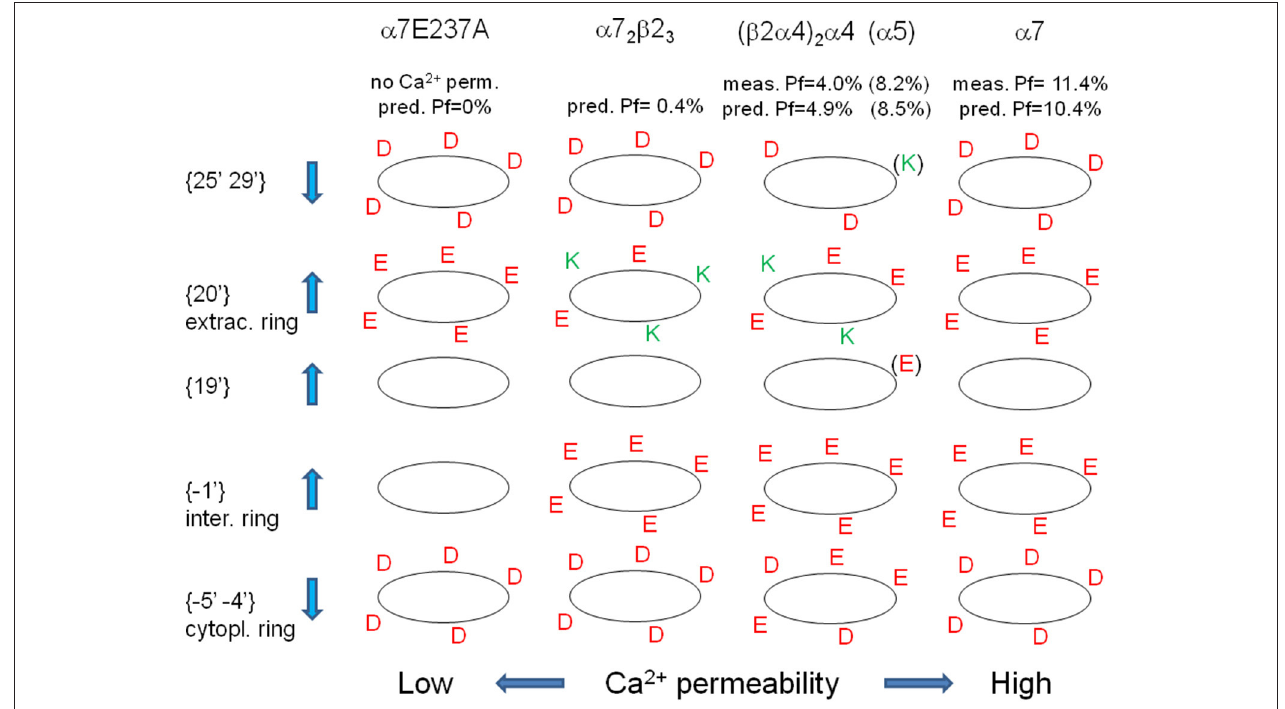
FIGURE 3 | Spatial distribution of charged amino acid residues in the proximity of the channel pore, for different nAChRs. For the indicated nAChRs the distribution of positive (green) and negative (red) amino acid residues is reported for each distinct TM2-flanking regions. Up- and down-wards arrows indicate rings in which higher negativity is associated with higher or lower Ca 2 + permeability, respectively. In brackets the residues present if an α 5 subunit replace an α 4 subunit, yielding a strong increase in Ca 2 + permeability. For each nAChR measured and predicted Pf -values are reported (in brackets for α 5-contaning nAChRs).